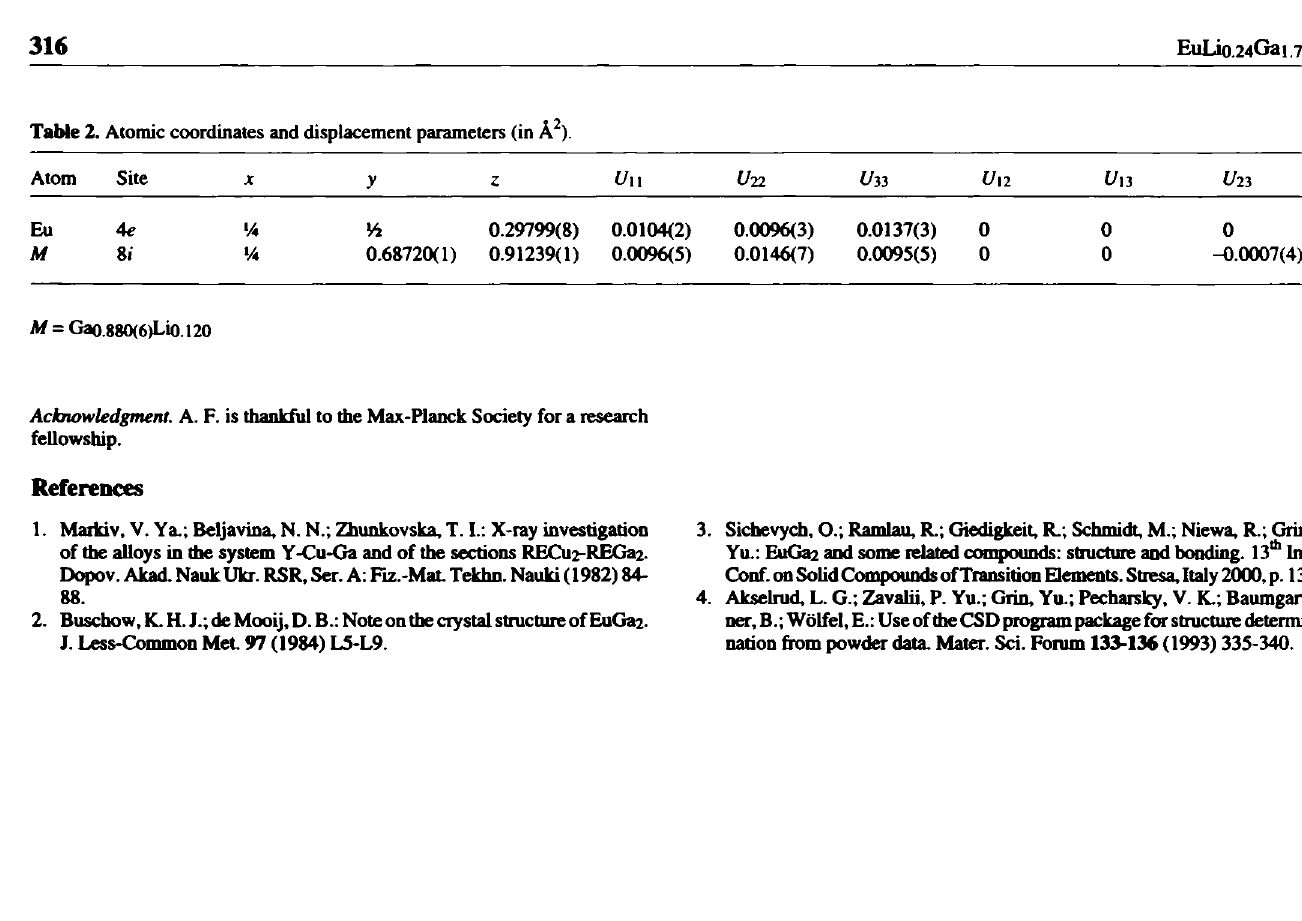
Table 2. Atomic coordinates and displacement parameters (in A 2